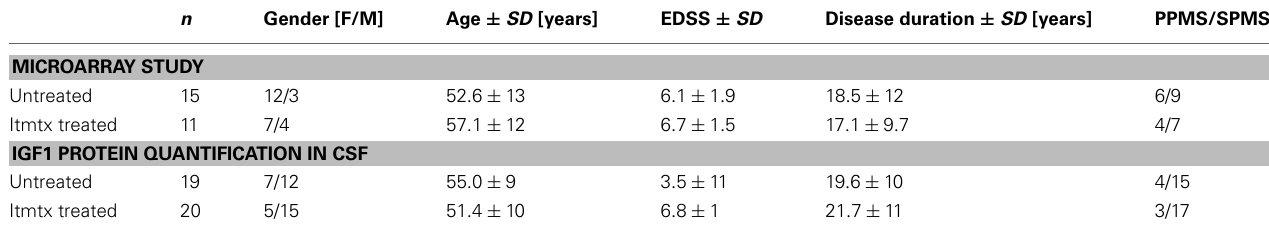
Table 1 | Patients’